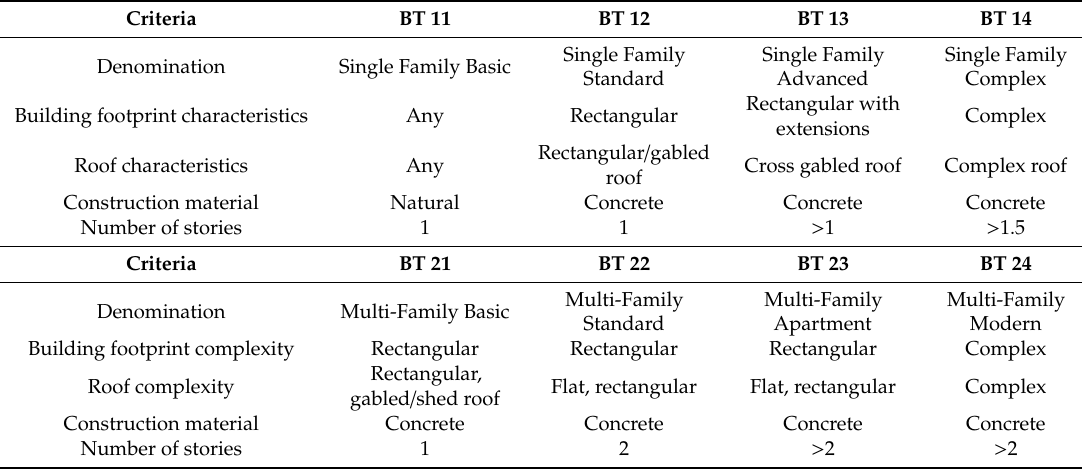
Table 3. Building typology for Belmopan, criteria to visual on-site di ff